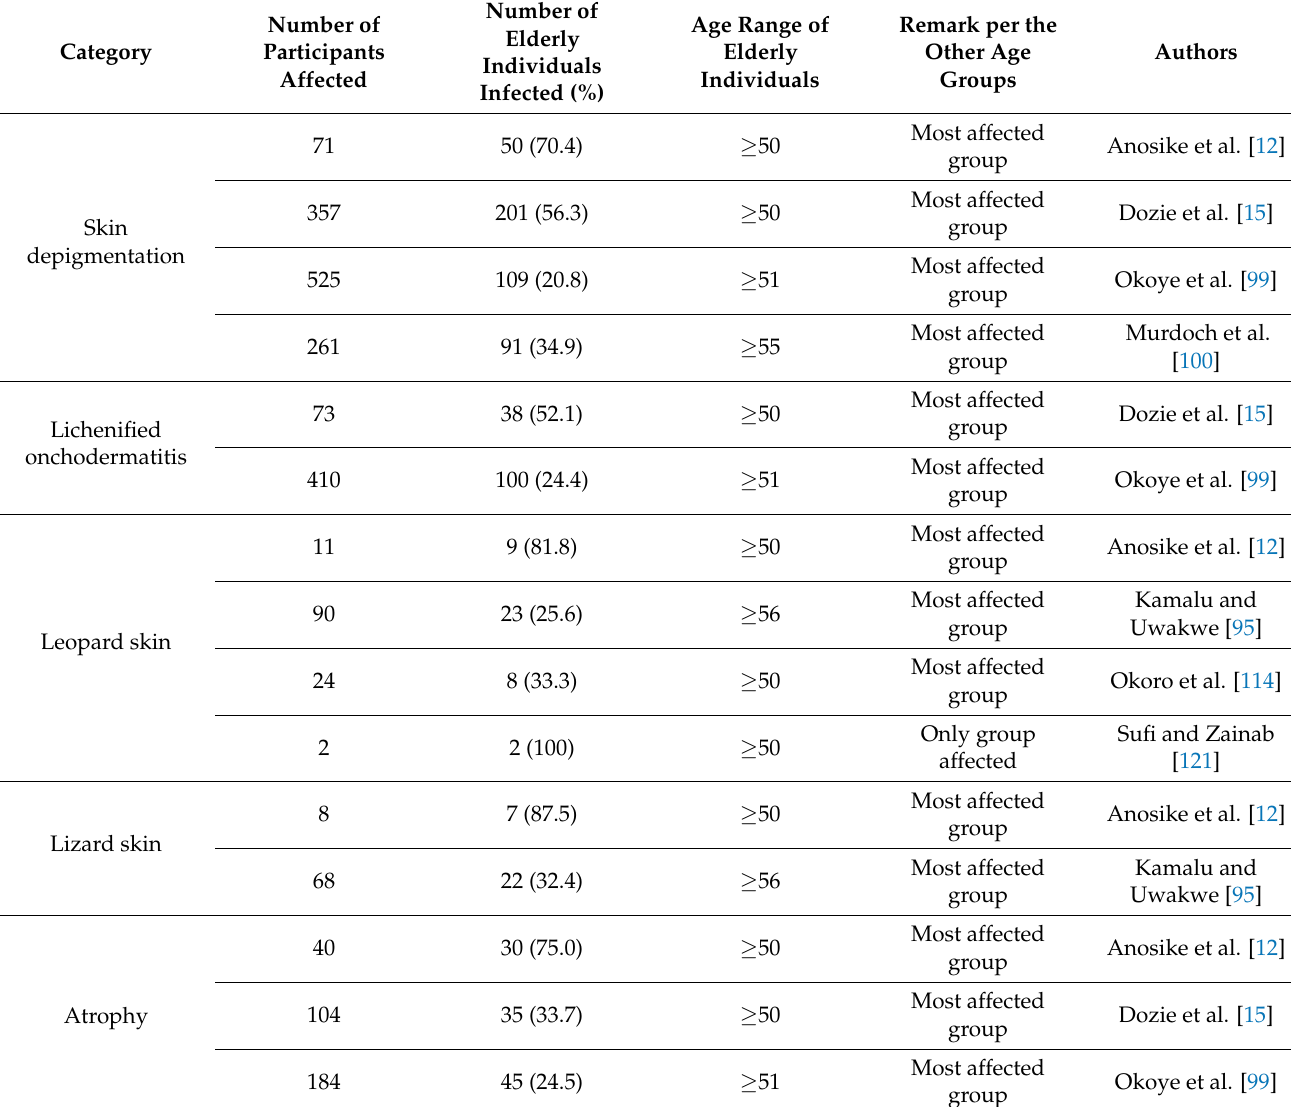
Table 3. Distribution of onchocercal skin lesions in the older